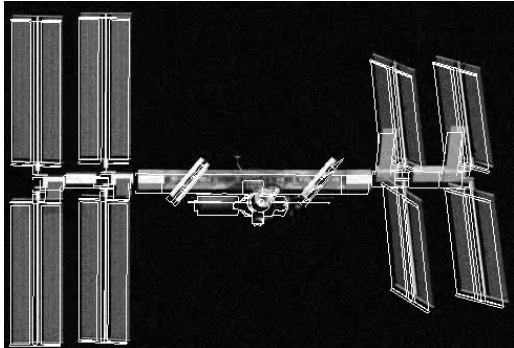
Figure 3. Contour generated by the initial orientation estimate